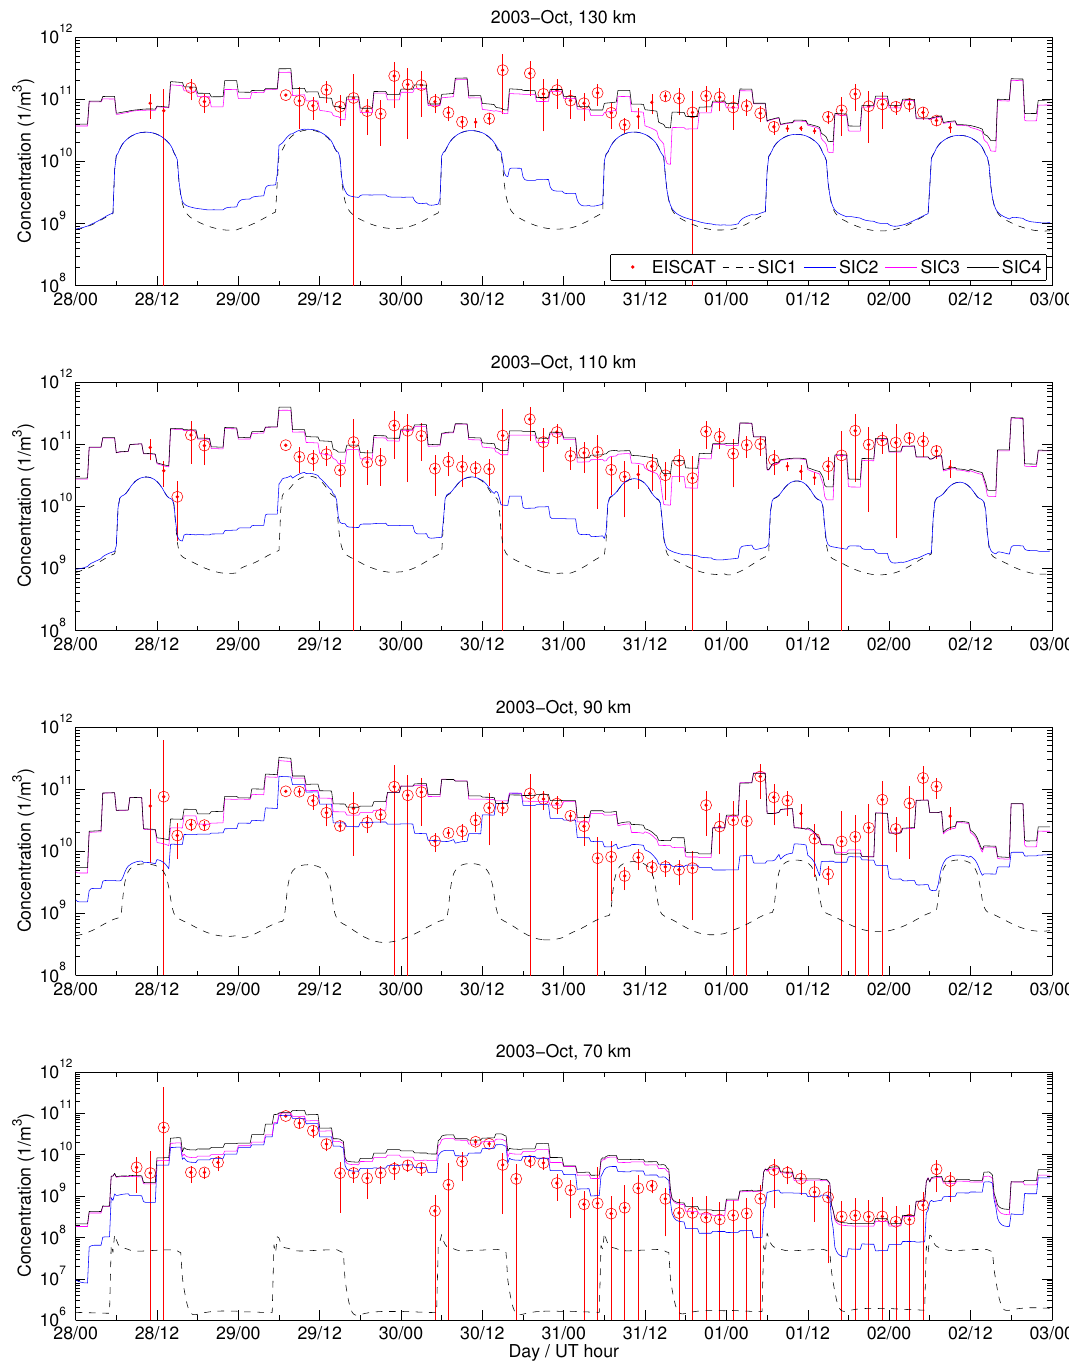
Figure 5. Electron concentration comparison between EISCAT and the four SIC model runs at selected altitudes for the October– November 2003 event (Case 1). The vertical red lines indicate the uncertainties (standard deviation) of the 2h EISCAT averages. The red circles indicate the data points that were selected for statistical